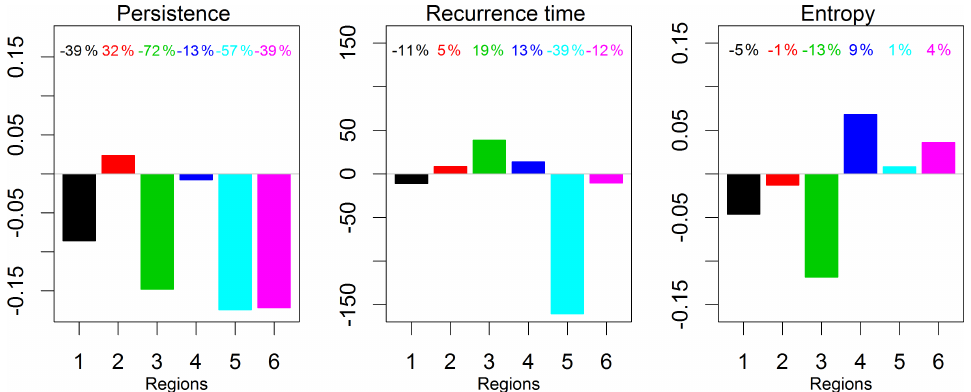
Figure 6. Change signal of descriptors for E-OBS observations: cold and wet extremes in winter (DJF) (Ta < 10th percentile and Pa > 75th percentile). Changes between the time periods 1951–1980 and 1981–2010. Percentages denote the relative change. The coloring corresponds to the regions in Fig.